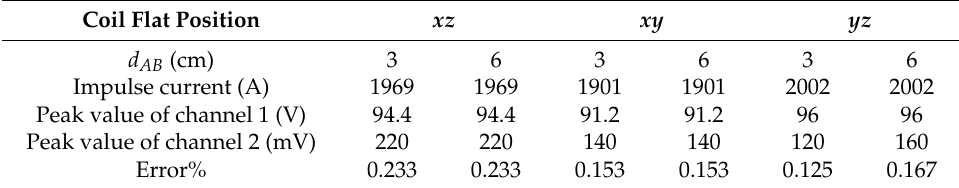
Figure 13. The test of adjacent wire interference. ( a ) Testing diagram of adjacent wire interference; ( b ) The waveform comparison at 2002 A and 3 cm. Table 5. Interference test of adjacent wire.